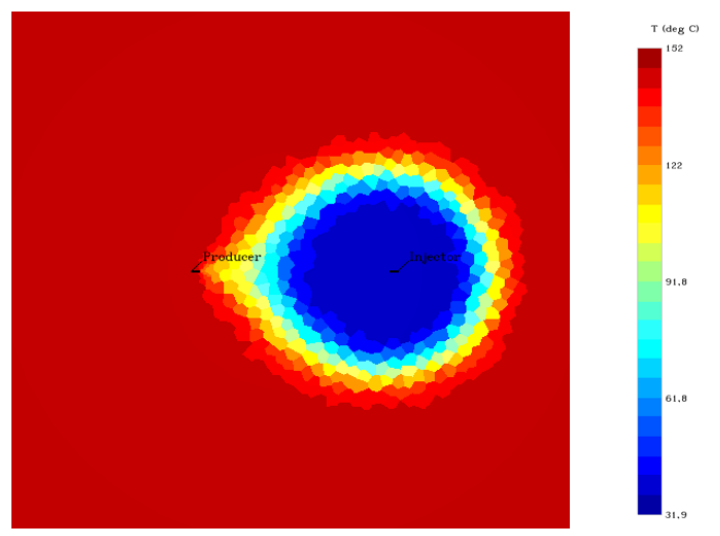
Figure 21. Model simulation of well doublet temperature distribution after 30 years of production—syn-rift phase.